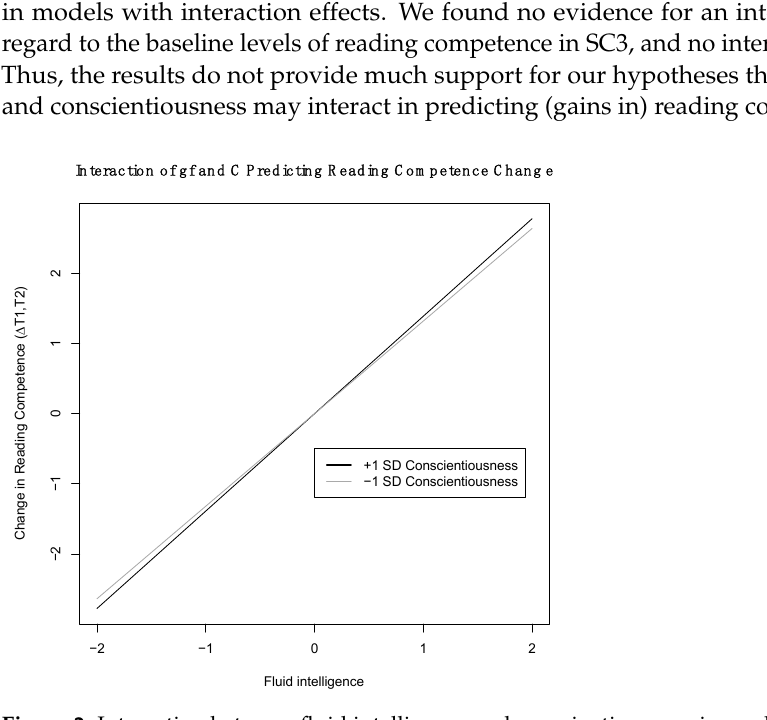
Figure 2. Interaction between fluid intelligence and conscientiousness in predicting reading competence change in SC3. Note. The dark gray line represents the association between fluid intelligence and change in reading competence for high levels of conscientiousness (+1 SD above the sample mean), whereas the light gray line represents the same association for low levels of conscientiousness (–1 SD below the sample mean).